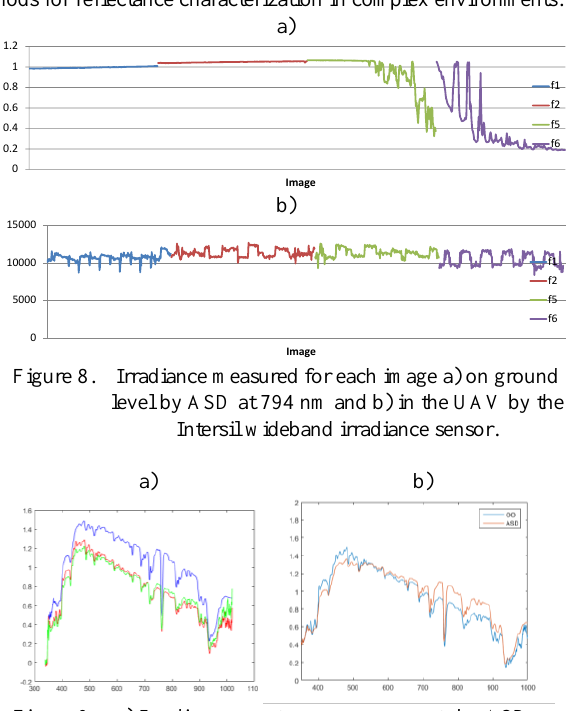
Figure 9. a) Irradiance spectrum measurements by ASD on ground (blue), OOU2000 close to ASD (green) and above canopy in UAV (red); OOU2000 irradiances are not calibrated. b) Calibrated OOU2000 in UAV and ASD on ground.